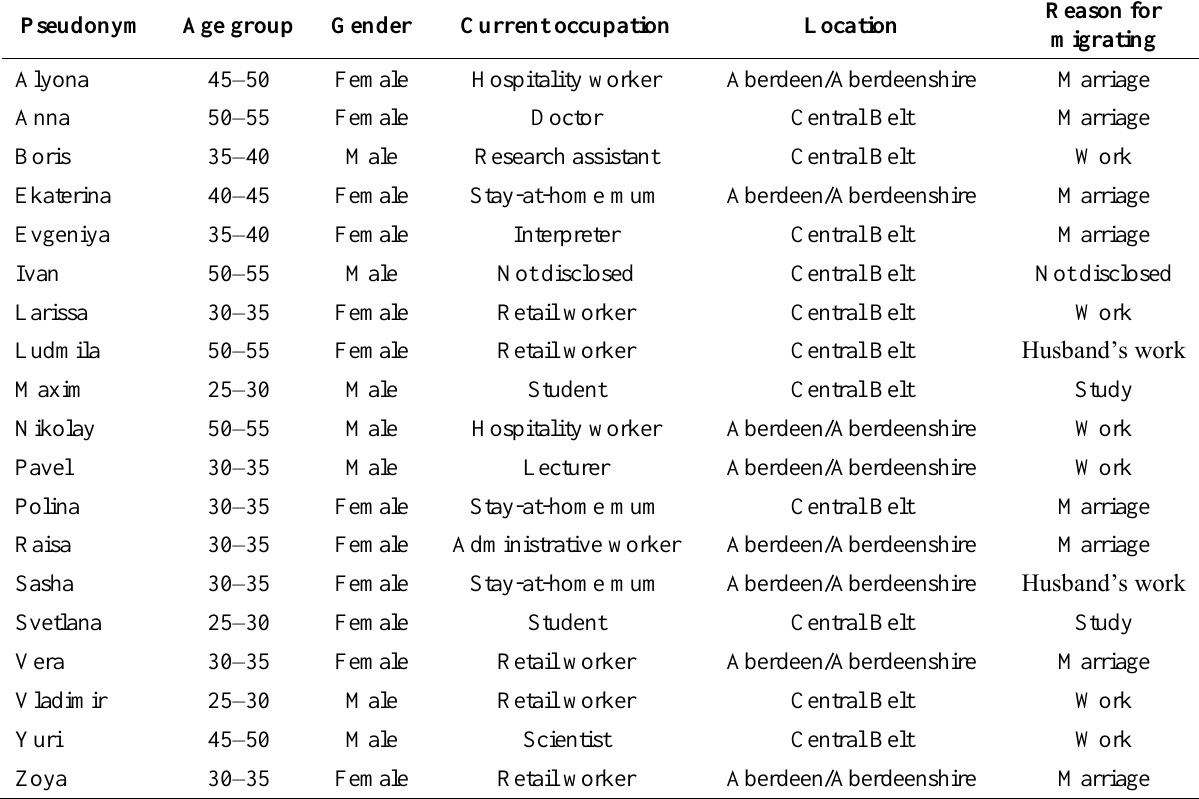
Table 1. Characteristics of